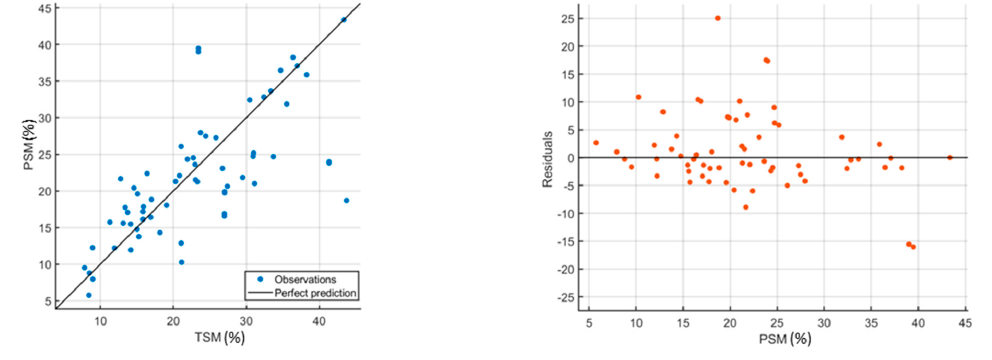
Figure 13. Scatterplots of the prediction performance of the five optimized ML models trained on the SAE-based augmented soil moisture dataset. Left: predicted versus true SMC. Right: residuals versus predicted soil moisture. Blue dots represent the observations, the diagonal line represents the perfect prediction, and the orange dots represent the residuals.